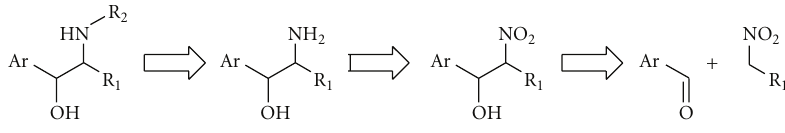
Figure 3: Retrosynthetic analysis of the B-13/D-MAPP sca ff